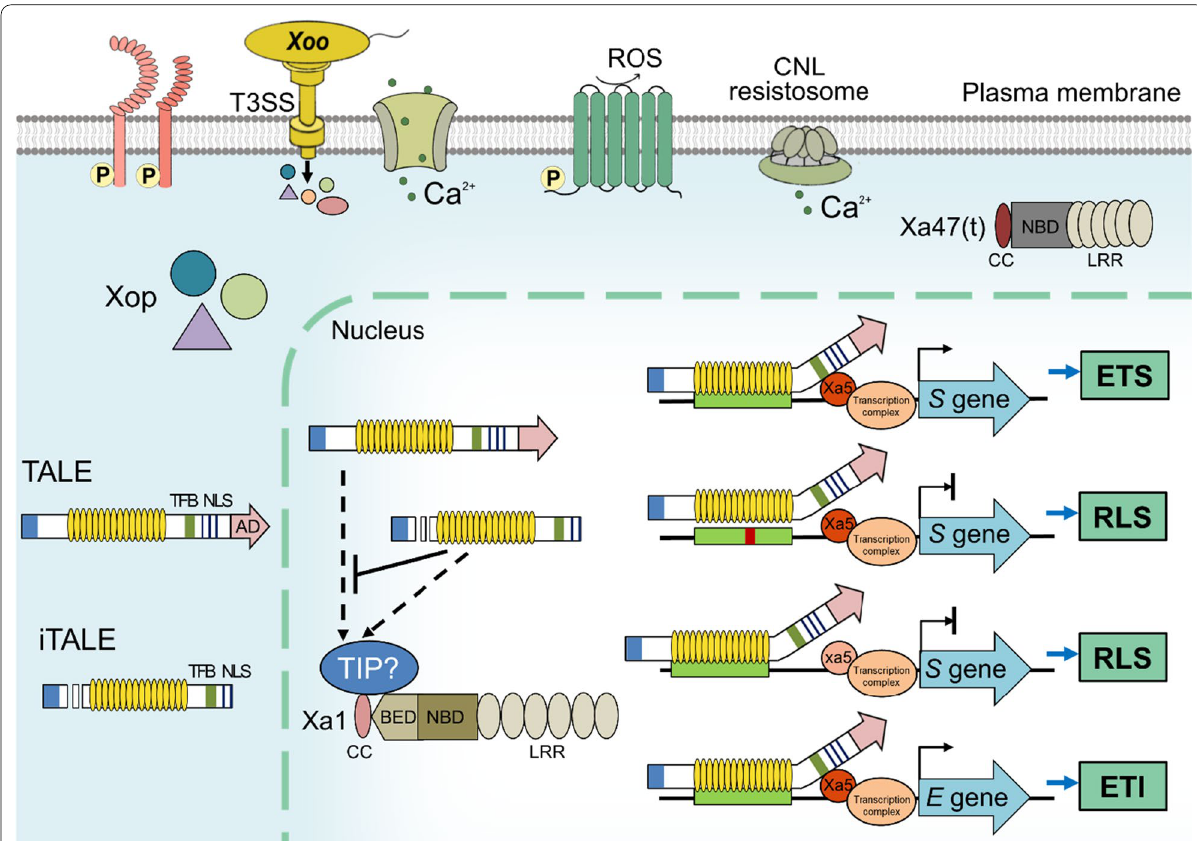
Fig. 1 Working model of rice immunity triggered by transcription activator-like effectors (TALEs) and Xops of Xanthomonas oryzae pv. oryzae ( Xoo ), the causal agent of bacterial blight (BB) in rice. Rice may use executor ( E ) genes to trap TALEs, or the BED domain of NLR-A type proteins (e.g., XA1 and its alleles) to recognize TALEs, or NLR-B type proteins (e.g., XA47) to recognize unknown type-III secretion effectors (T3SEs) for effector-triggered immunity (ETI) against Xoo . On the other hand, Xoo evolves iTALE to suppress XA1-mediated resistance via an unknown TIP1 in rice. These ETIs